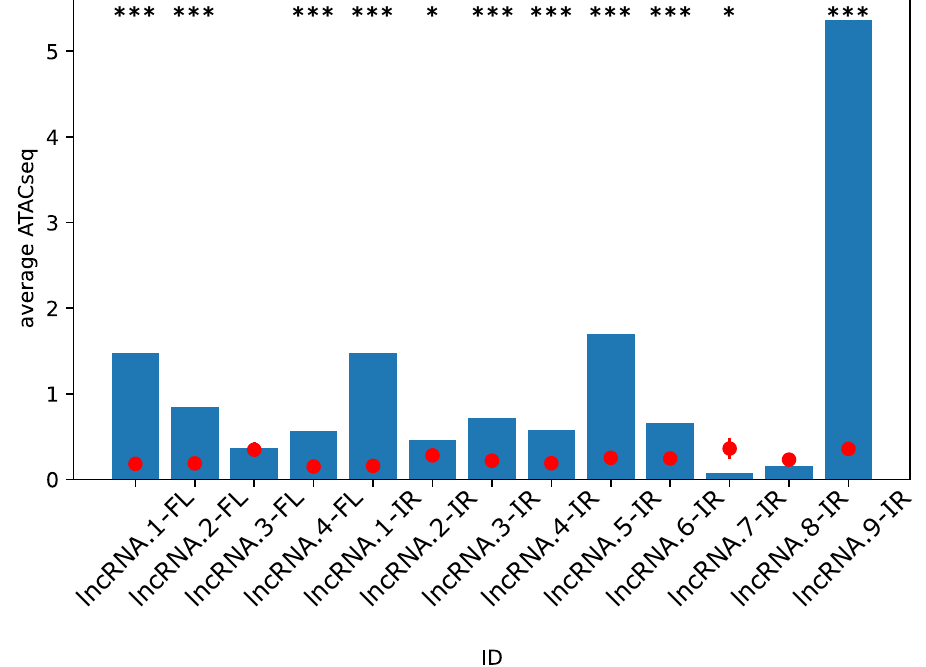
Figure 3. The significant accessibility of DE-lncRNAs in the genome. Average ATAC-seq signal in the 13 lncRNAs (bars) as compared to that of random locations with similar width in the genome (red dot). Error bars depict S.E.M. (*P < 0.05, ***P <